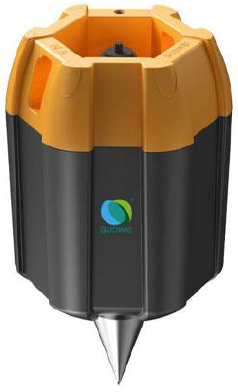
Figure 4. Layout of measuring points and goaf scope of Coal Seam #2.